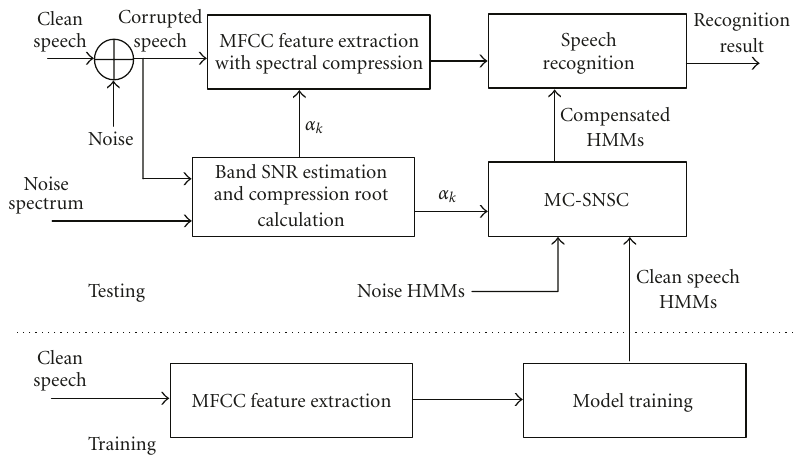
Figure 2: Processing stages for MC-SNSC